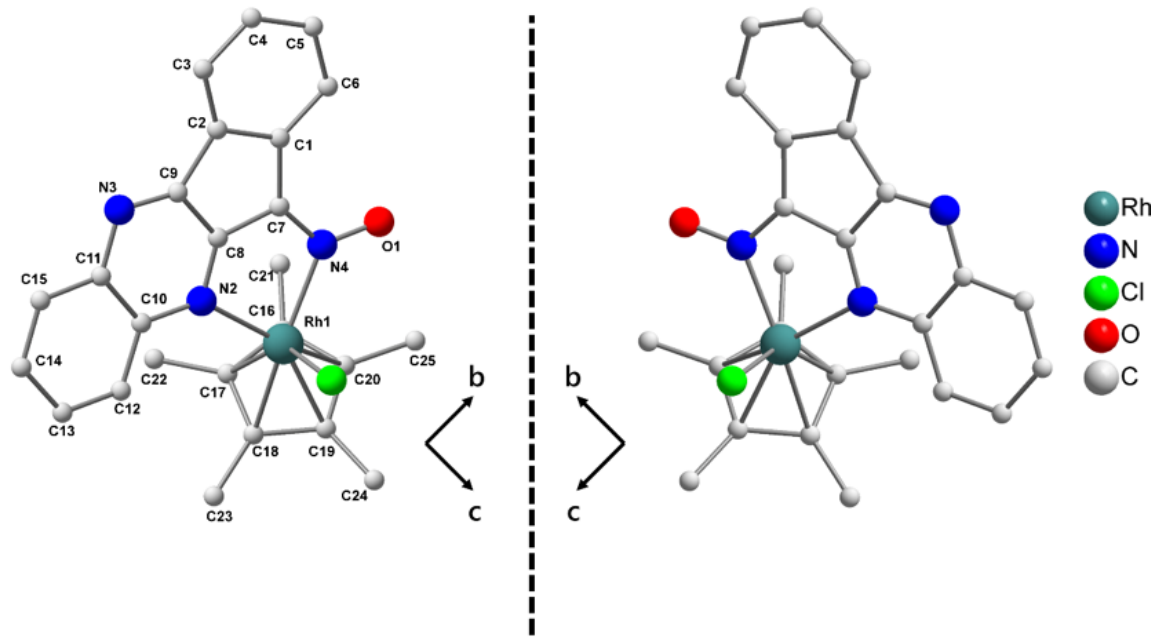
Figure 4. X-ray molecular structures of S -2 ( left ) and R -2 ( right ). Hydrogen atoms are omitted for clarity. Atom numbering is shown only for one of the enantiomers.